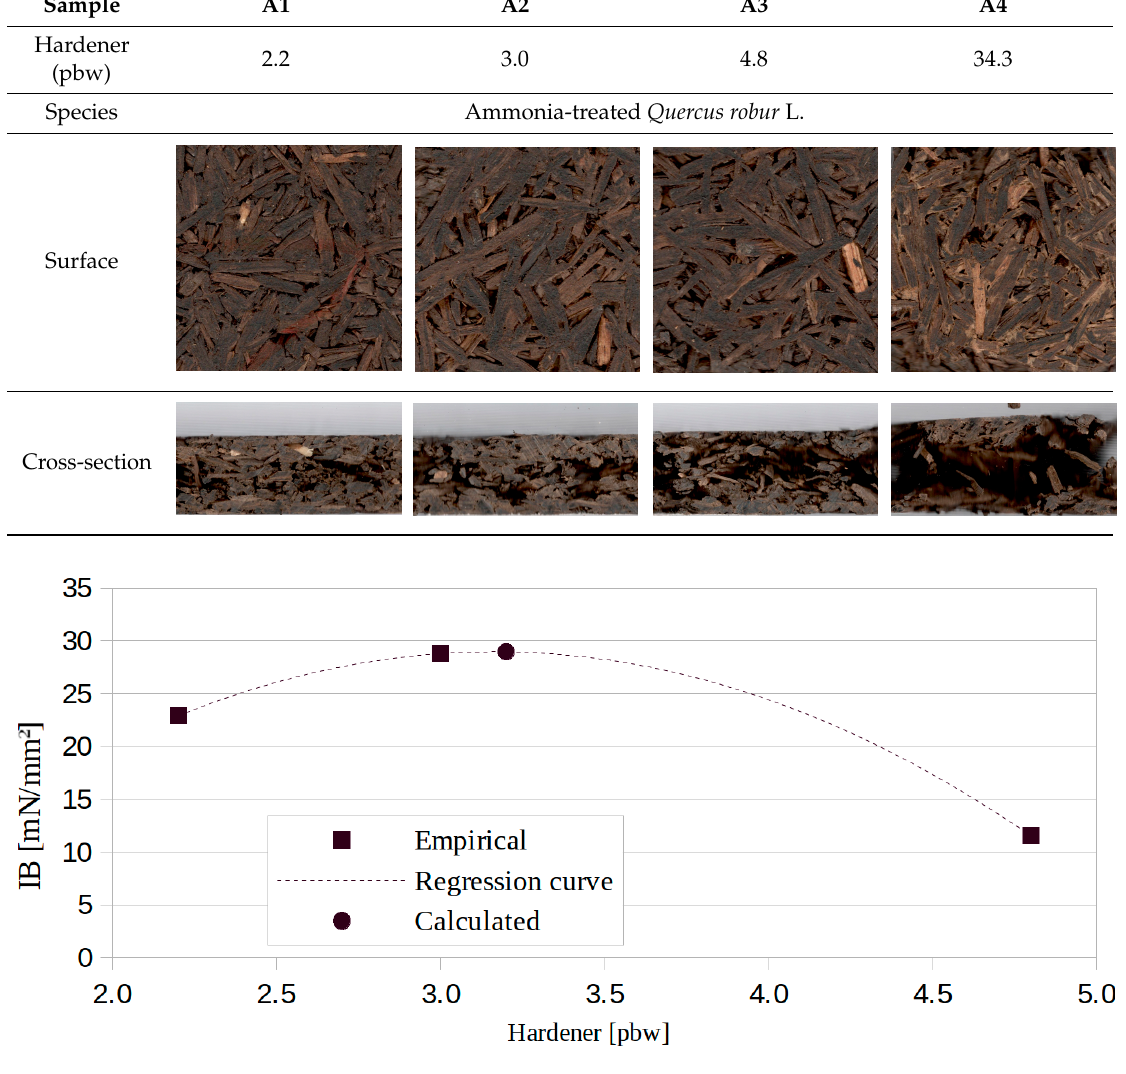
Figure 6. Empirical and predicted IB of particleboards made of ammonia-treated oak.